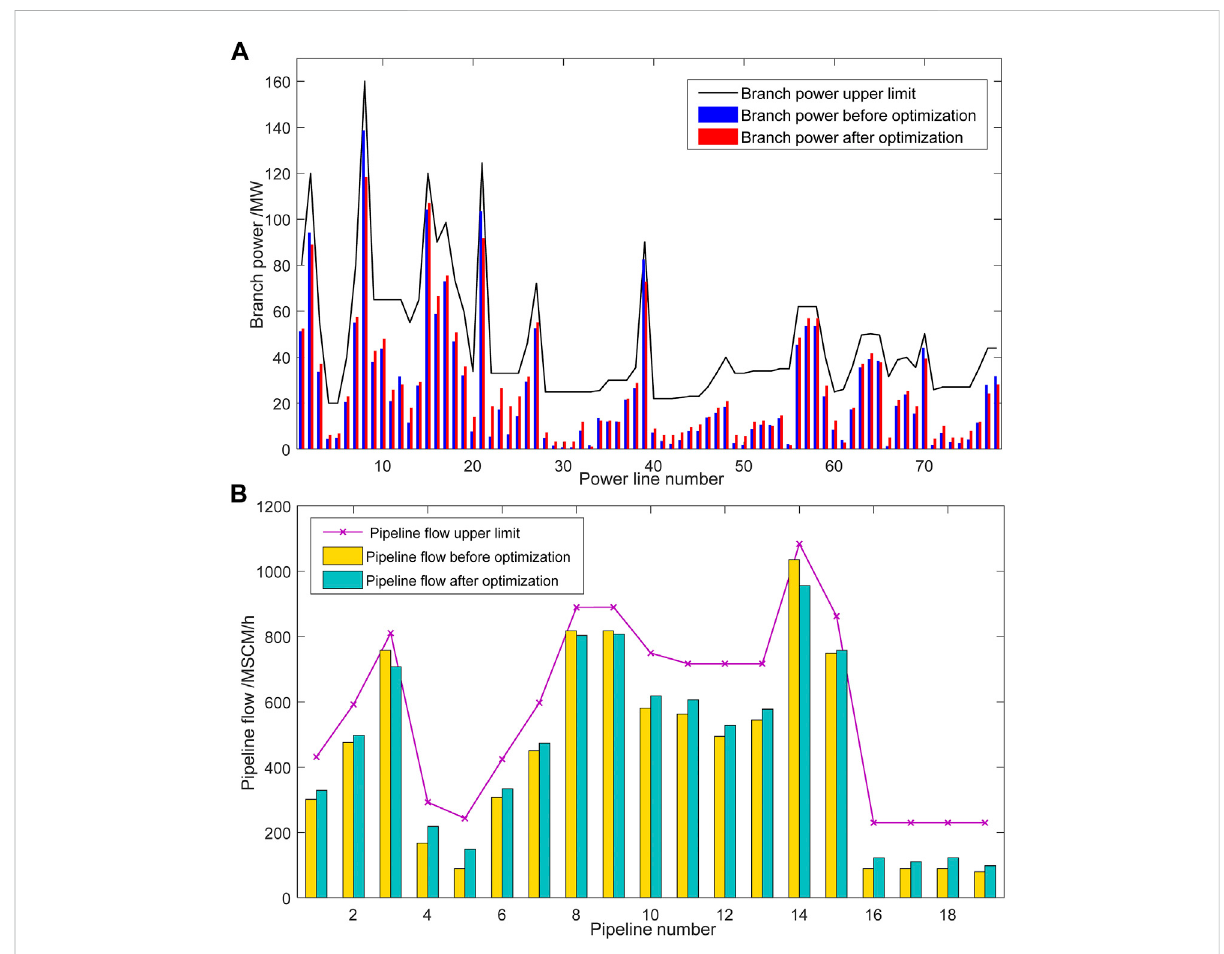
FIGURE 13 (A) Comparison of branch power results before and after optimization, (B) Comparison of pipeline fl ow optimization results before and after optimization.